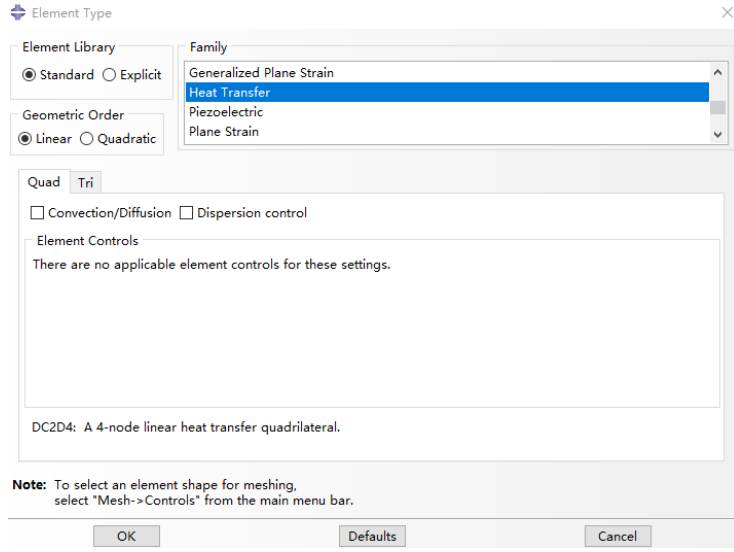
Figure 4. The element type of moisture diffusion model in Abaqus.